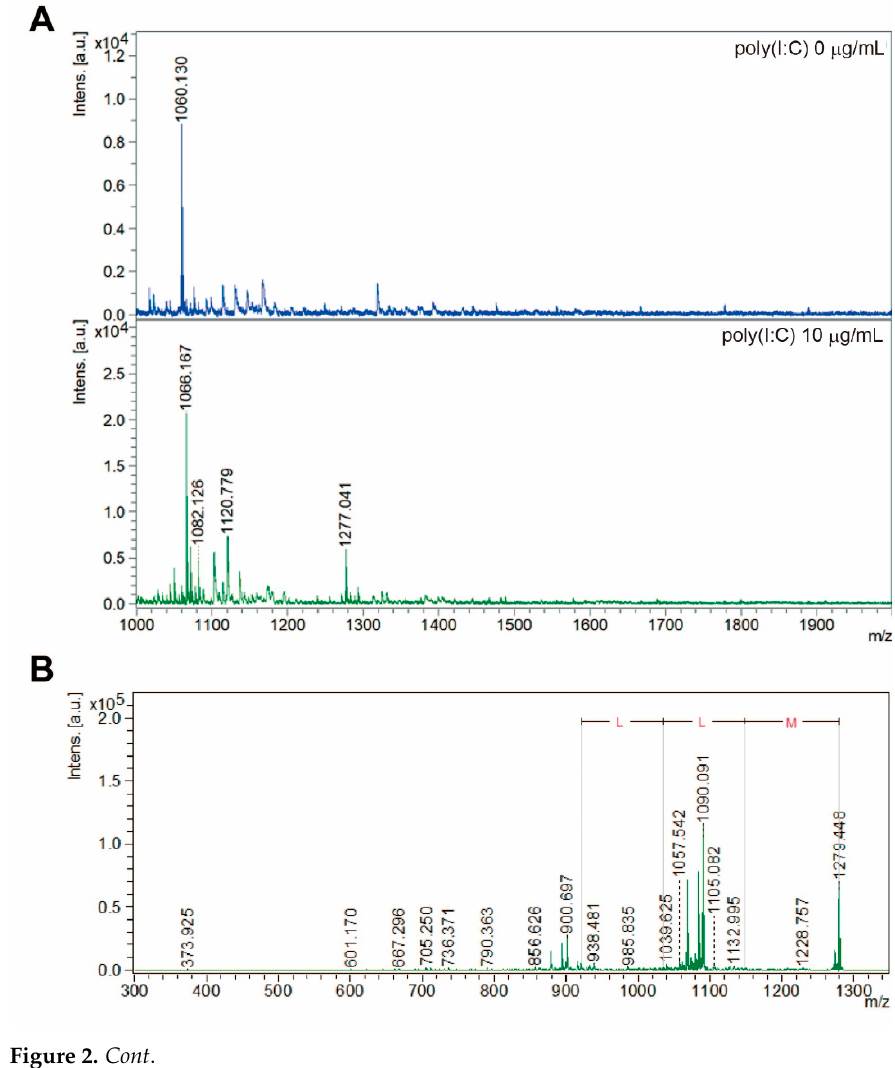
Figure 2. N-terminal fragments of SEAP SP in exosomes released from HEK-Blue hTLR3 cells. ( A ) The peptide solution extracted from exosomes of HEK-Blue hTLR3 cells in the presence of poly(I:C) at 0–10 μ g/mL for three days was analyzed by MALDI-TOF MS. ( B ) MS/MS analysis of peaks at m / z